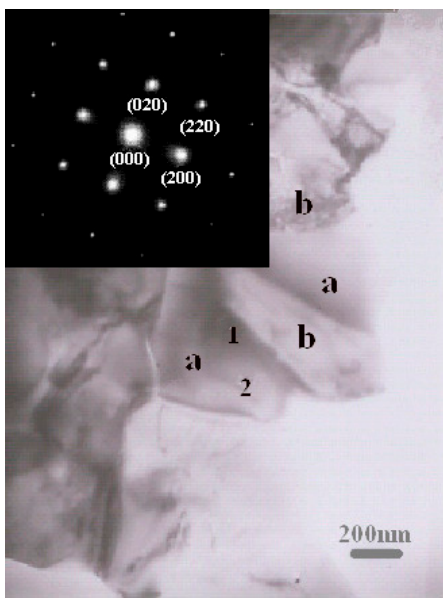
Figure 3. Bright-field transmission electron microscopy (TEM) images of the cermet coating prepared by laser cladding.